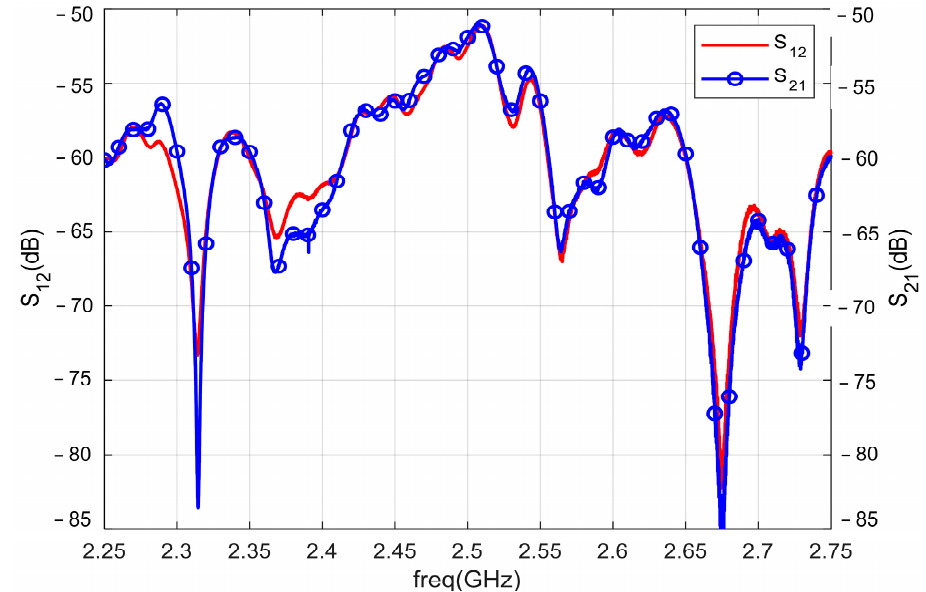
Figure 16. Z11 and S21 parameters of the antenna.